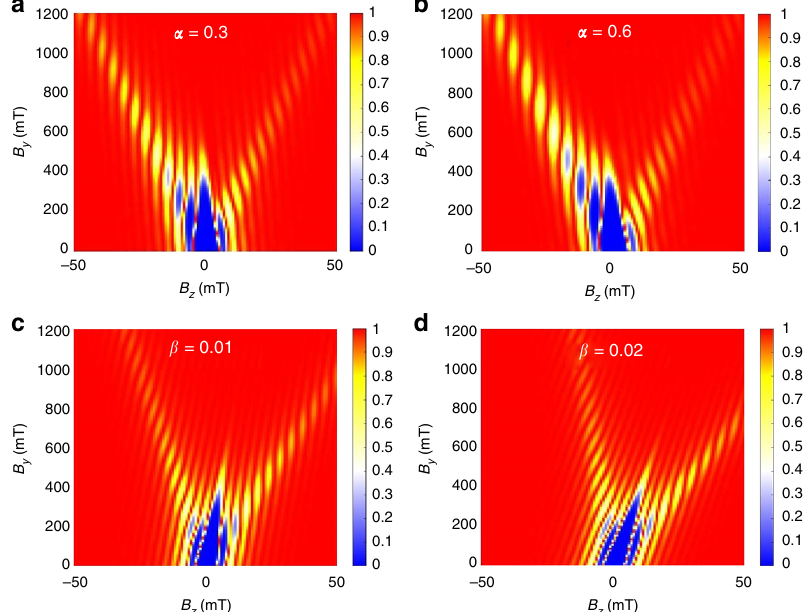
Fig. 5 Simulation of effect of junction asymmetry and fi eld inhomogeneity. The width and fi eld asymmetry dependence of the Fraunhofer pattern. a , b When a width asymmetry factor α is added to the model, we fi nd that the signal becomes asymmetric between positive and negative B z . Here, the amplitude of the left side lobes increases relative to the amplitude of the right side lobes. We used the values α = 0.3, 0.6 respectively. c , d When the asymmetry factor β is introduced to the model, the Fraunhofer patterns are shifted along B z , which can be seen as a tilt introduced to the 2D differential resistance map. We used β = 0.01, 0.02